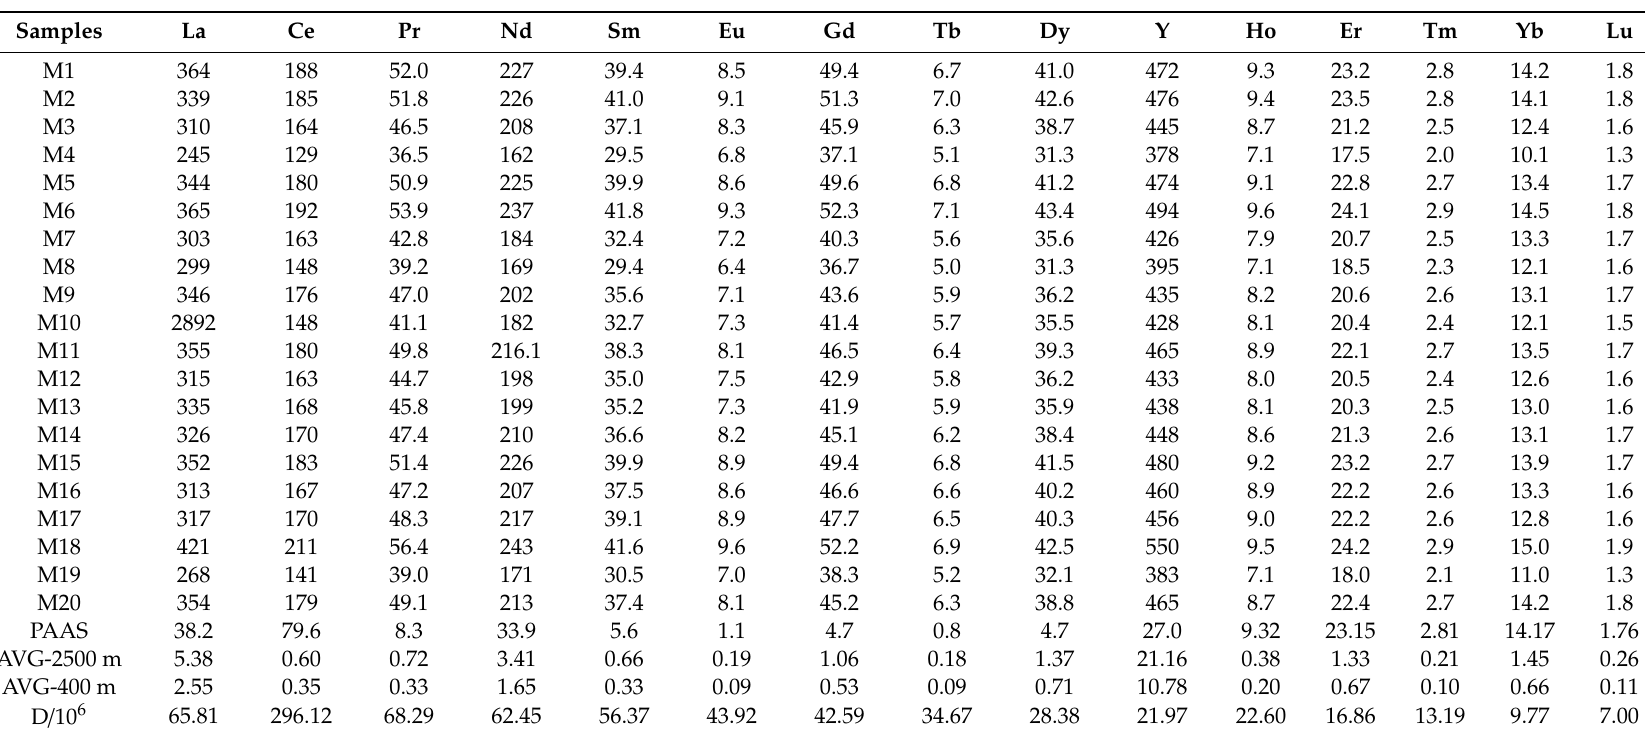
Table 2. REY contents (in ppm) of the intraclastic apatite grains, determined by laser ablation inductively coupled plasma Mass spectrometry (LA-ICP-MS).